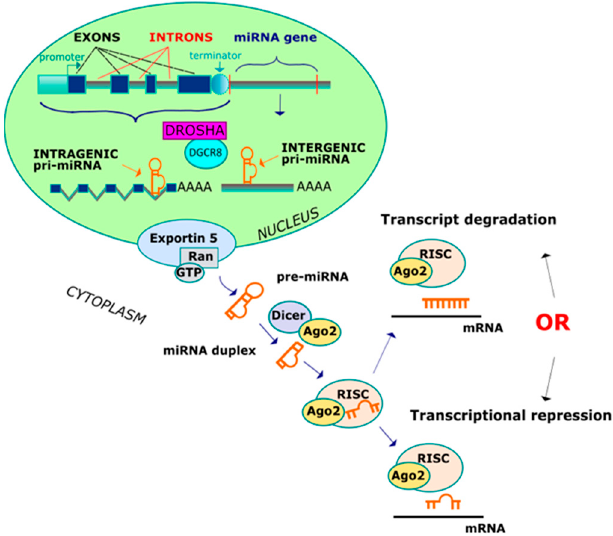
Figure 1. Two ways leading to the creation of miRNA .